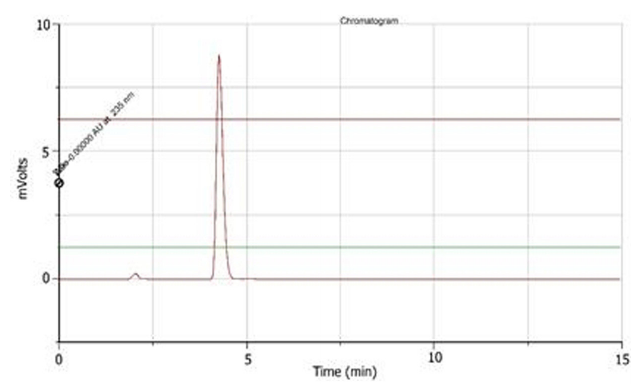
FIGURE 6 - Chromatogram of the nifedipine solution at 10 µg/ mL obtained by HPLC using Sigma-Aldrich Kromasil® C18 column (dimensions 250 x 4.6 mm; 5 µm), mobile phase of acetonitrile:methanol:water in 35:35:30 proportion, flow of 1.5 mL/min, ultraviolet detector (UV) with detection wavelength (λ) of 235 nm, temperature of 40 o C. TABLE V - Linear regression results and limit of quantification and limit of detection